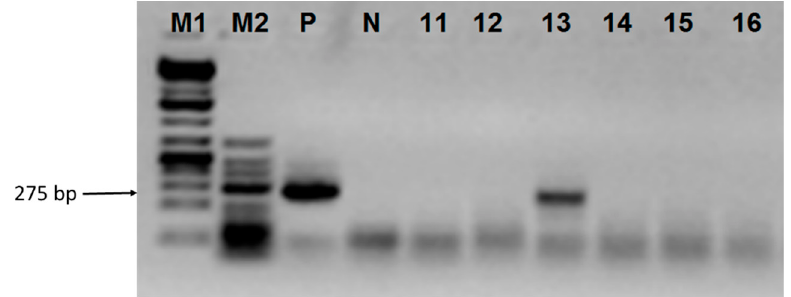
Figure 4. Electrophoretic analysis of semi-nested PCR amplification products. M1, Gene Ruler 1 kb Plus DNA Ladder; M2, GeneRuler Low Range DNA Ladder, Fermentas, P , positive control (blood DNA of calf experimentally inoculated with BFV), N, negative reaction control, samples no. 113/11– 113-16.